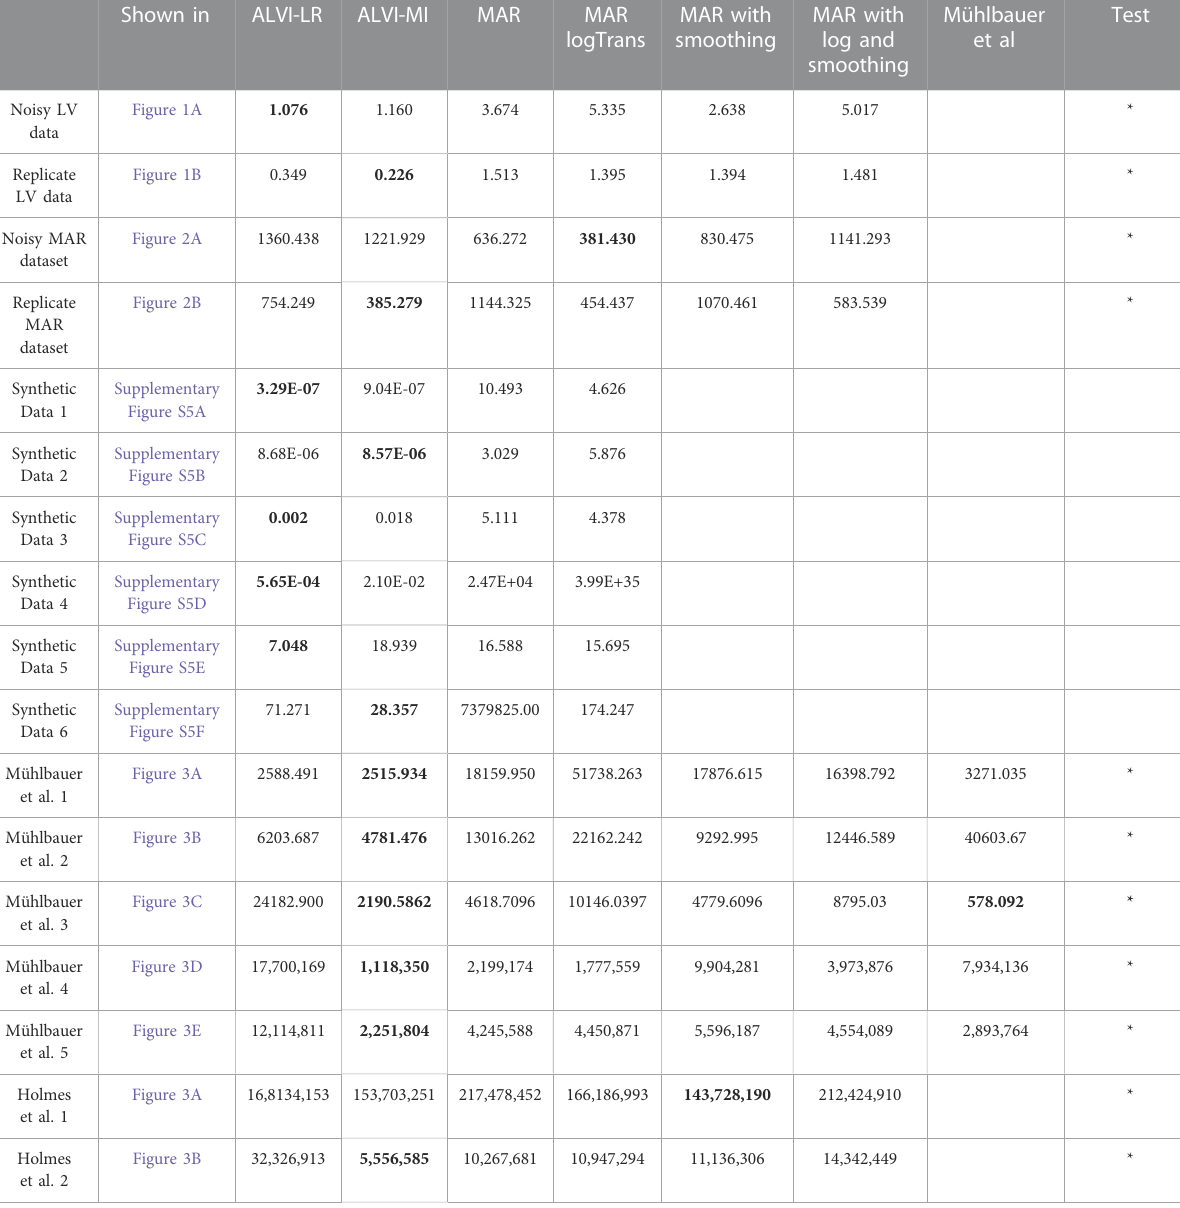
TABLE 1 Sum of squared errors (SSE) of data fi ts for all experiments with ALVI-LR (linear regression), ALVI-MI (matrix inversion) and four variants of the MAR methods. We also include SSEs for the estimates obtained by Mühlbauer et al. (2020) for LV data presented in Figure 4. Bold values identify the lowest SSE score for each example. Examples used in the Wilcoxon rank test are marked with asterisks. Shown